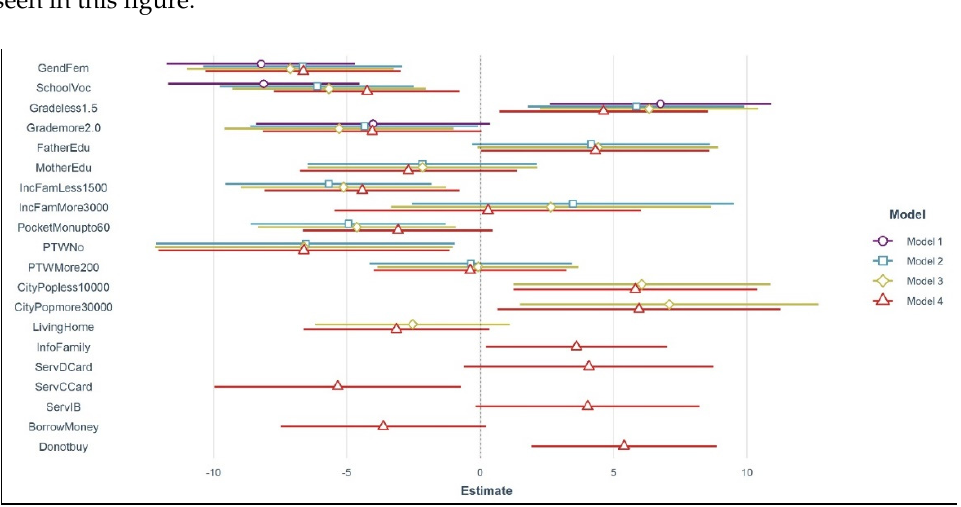
Figure 7. Parameter estimates for all Tobit regression models.